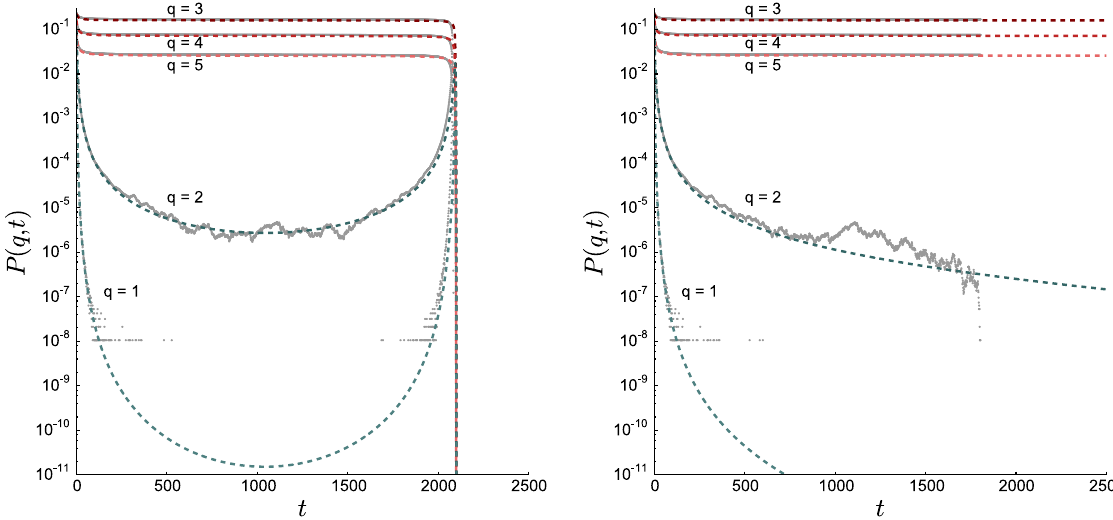
FIG. 4. Time evolution of the network degree distribution during the k -core pruning process, for an Erd ő s-Rényi network with k ¼ 3 . Each line shows P ð q; t Þ for a different value of q , in order from top to bottom, q ¼ 3 ; 4 ; 5 ; 2 ; 1 , as labeled. Left: Initial mean degree h q i ¼ 3 . 3509 . Right: Initial mean degree h q i ¼ 3 . 350 92 . Also shown are traces from simulation runs for an Erd ő s-Rényi network with N ¼ 10 8 vertices and mean degree 3.3511 (left) and 3.351 11 (right). Note that the critical point for a particular realization is a stochastic quantity, so the mean degrees for matching theory and simulation are not necessarily equal. Theoretical curves are chosen to be near the critical point and to have a similar total time.